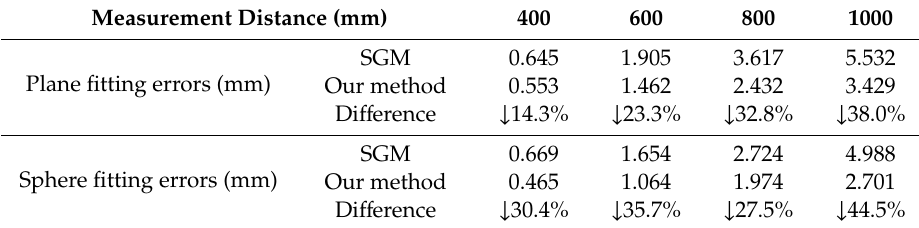
Table 2. Accuracy comparison between SGM and improved SGM.